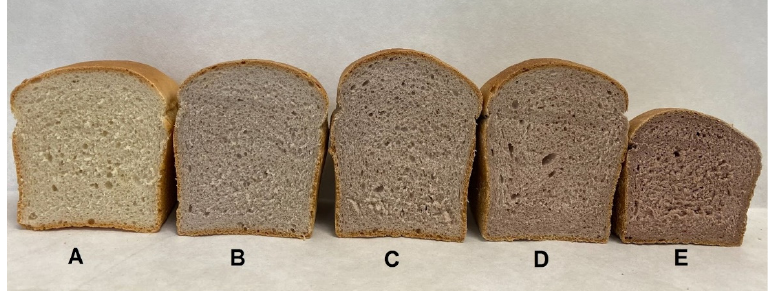
Figure 1. Experimental bread loaves. ( A ) control sample, ( B ) 1% Cornelian cherry powder addition, ( C ) 2% Cornelian cherry powder addition, ( D ) 5% Cornelian cherry powder addition, and ( E ) 10% Cornelian cherry powder addition.